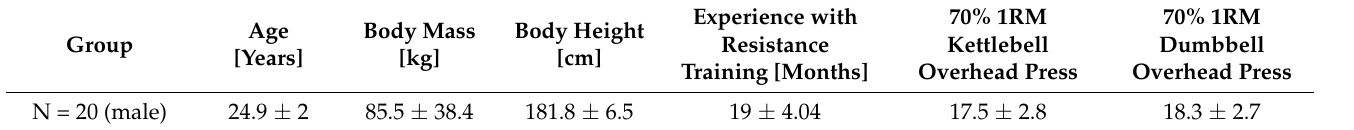
Table 1. Participants’ characteristics (mean ±